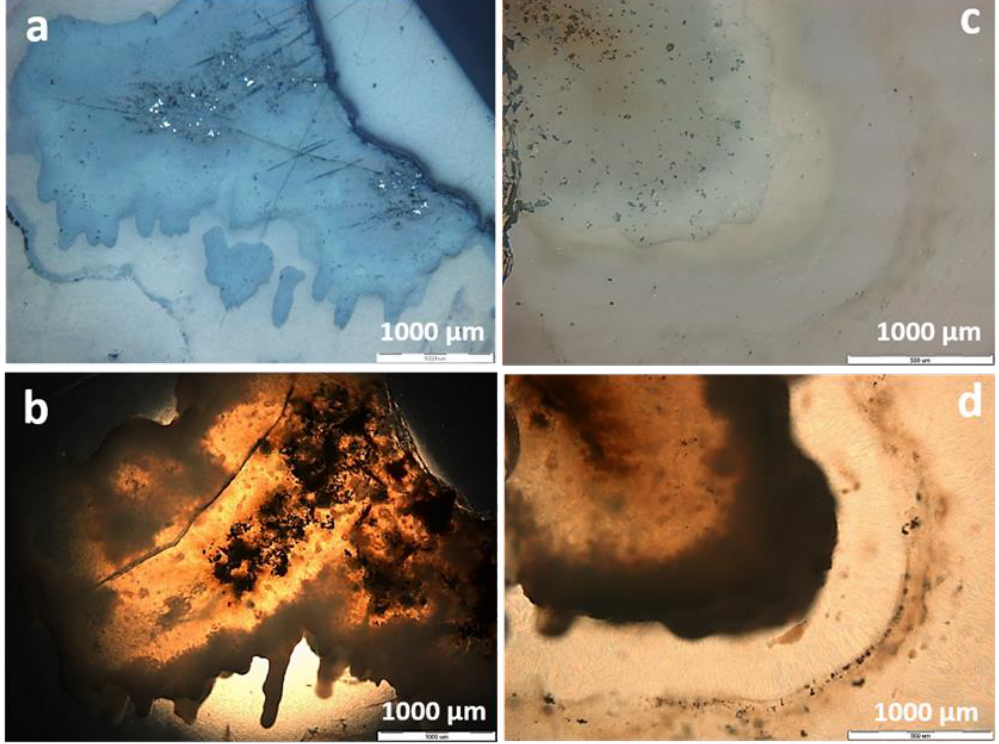
Figure 7. Microstructure of agate No. 7 (Figure 4c) with near inclusions of copper sulphides: ( a , c ) in reflected light; ( b , d ) in transmitted light. A thin section of the agate.